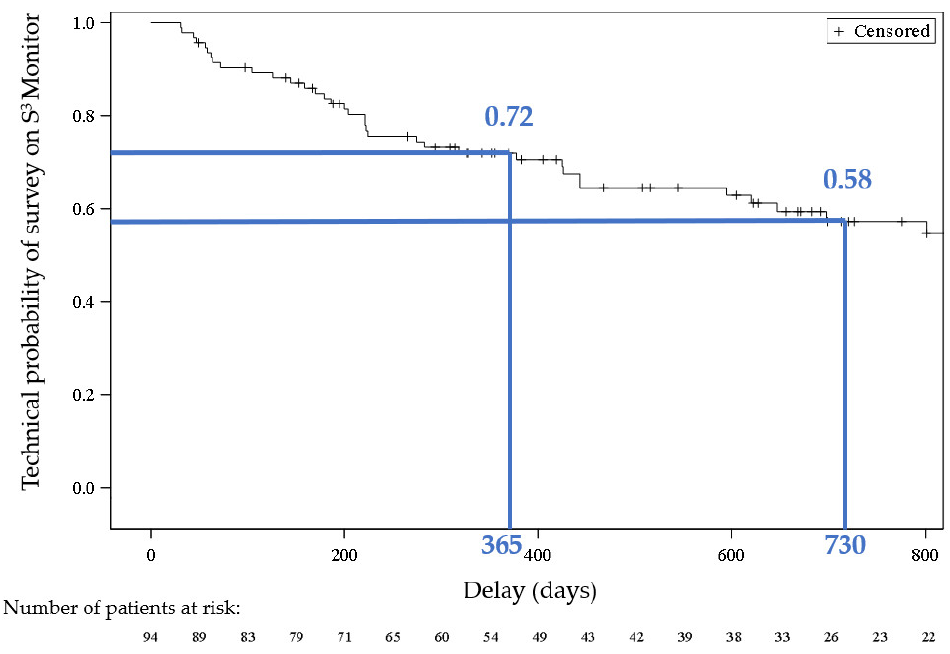
Figure 6. Technical survival probability of continuing HHD with S 3 monitor during the follow-up period. The evolution of the professional situation is displayed in Figure 7.